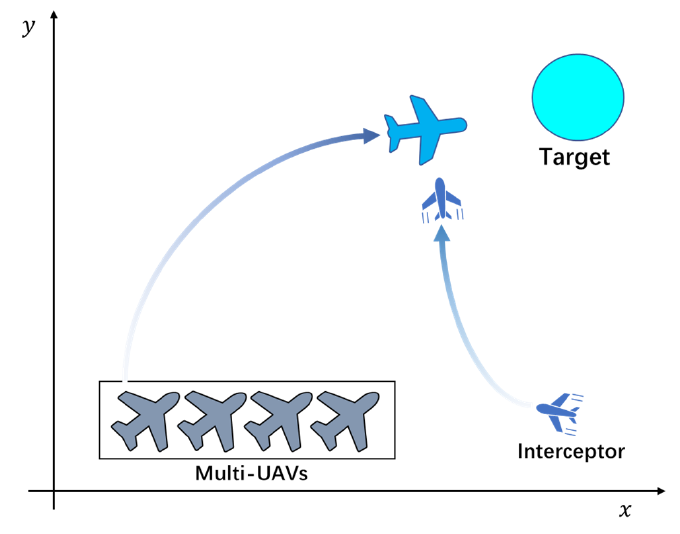
Figure 1. The motion scene of the multi-UAVs.